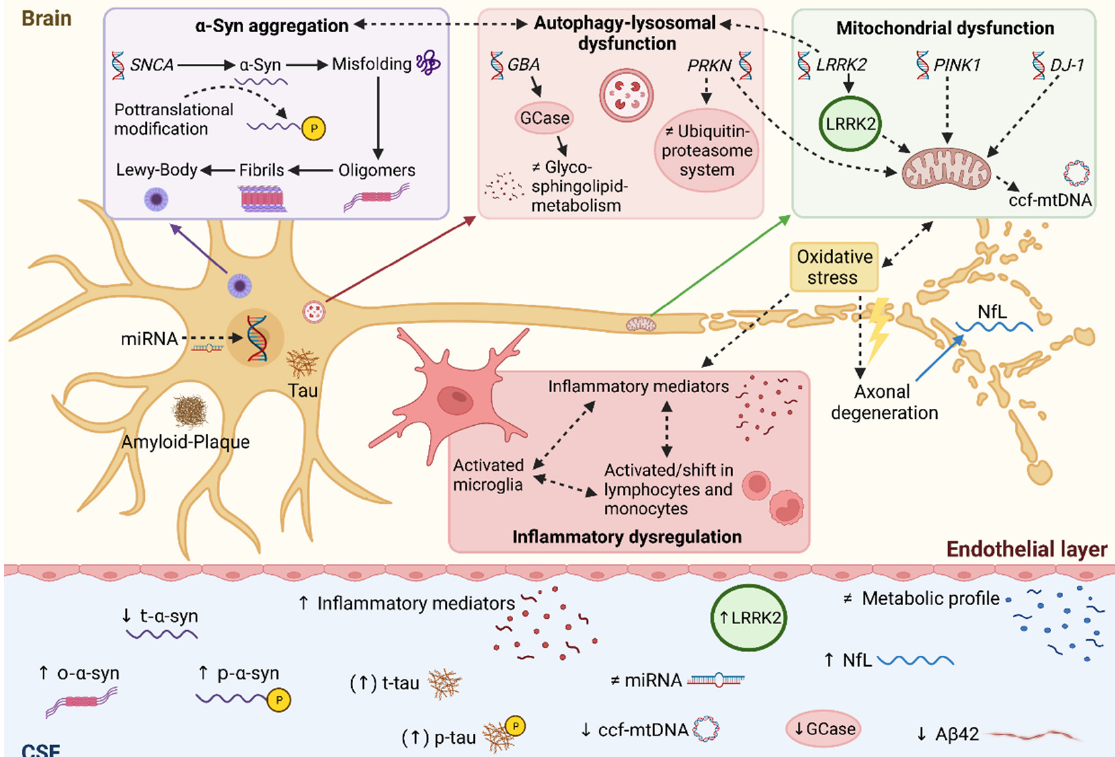
Figure 1. Synopsis of CSF biomarkers under investigation in Parkinson’s disease. Pathophysiological links between autophagy-lysosomal disruption, mitochondrial dysfunction and neuroinflammation leading to α -synuclein accumulation. Accordingly, molecular changes can be detected in CSF serving as candidate biomarkers in Parkinson’s disease. Solid lines represent direct relations, whereas dotted lines represent multi-step processes. ↑ increased; ↓ decreased; ≠ unaltered; A β 42, amyloid beta peptide 1-42; α -syn, α -synuclein; ccf-mtDNA, circulating cell-free mitochondrial DNA; miRNA, microRNA; NfL, neurofilament light chain; o- α -syn, oligomeric α -synuclein; p- α -syn, phosphorylated α -synuclein; t- α -syn, total α -synuclein; p-tau, phosphorylated tau; t-tau, total tau protein. Created with BioRender.com (accessed on 8 January 2022).